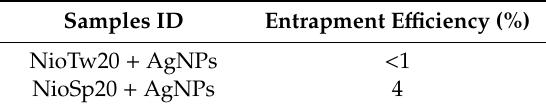
Table 2. The entrapment efficiency in percentage of AgNPs in niosomes.